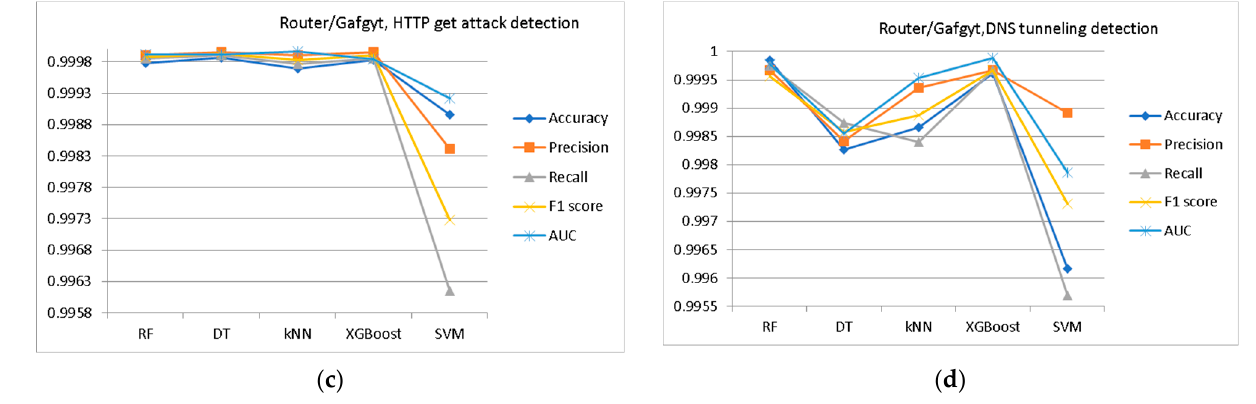
Figure 3. Comparison of different MLA efficiencies (decision tree—DT, random forest—RF, K- nearest neighbor—KNN, extreme gradient boosting—XGBoost, support vector machine—SVM) for Router/Gafgyt botnet detection: ( a ) TCP attack; ( b ) UDP attack; ( c ) HTTP GET attack; ( d ) DNS tunneling.